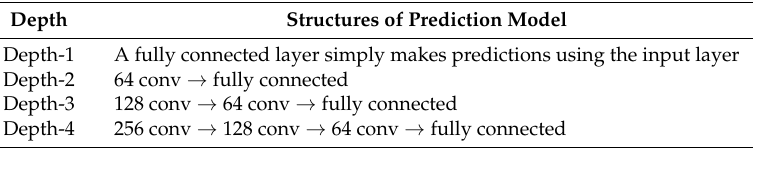
Table 1. Different depths for CNN.